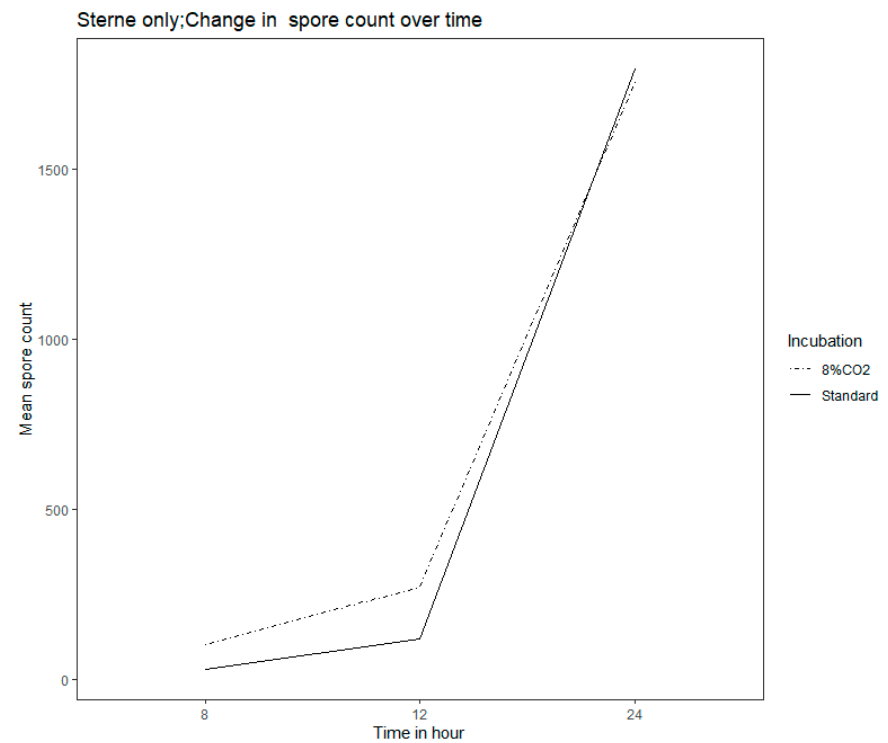
Figure A6. ( A ): Median spore counts for Bacillus anthracis strains under standard conditions and 8% CO 2 . ( B ): Change in cell counts for Bacillus anthracis DS201579 strain under standard conditions and 8% CO 2 . ( C ): Change in mean cell counts for Bacillus anthracis Sterne strain under standard conditions and 8% CO 2 . ( D ): Change in mean spore counts for Bacillus anthracis DS201579 strain under standard conditions and 8% CO 2 . ( E ): Change in mean spore counts for Bacillus anthracis Sterne strain under standard conditions and 8% CO 2 . Figure A7A–F: There are di ff erences in changes in Bacillus anthracis spore and cell counts based on bicarbonate treatment. Those with bicarbonate treatment don’t produce nearly as many cells because spores do not germinate in the first place.